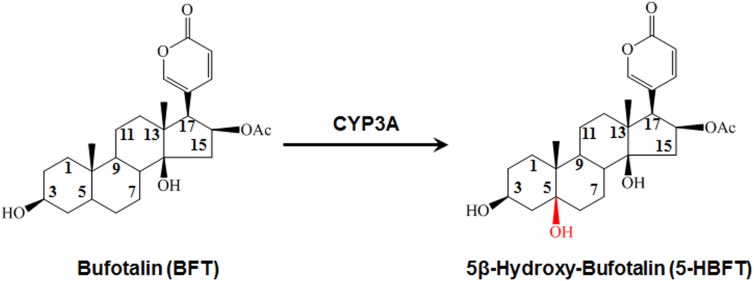
The 5β-hydroxylation of BFT in HLM.